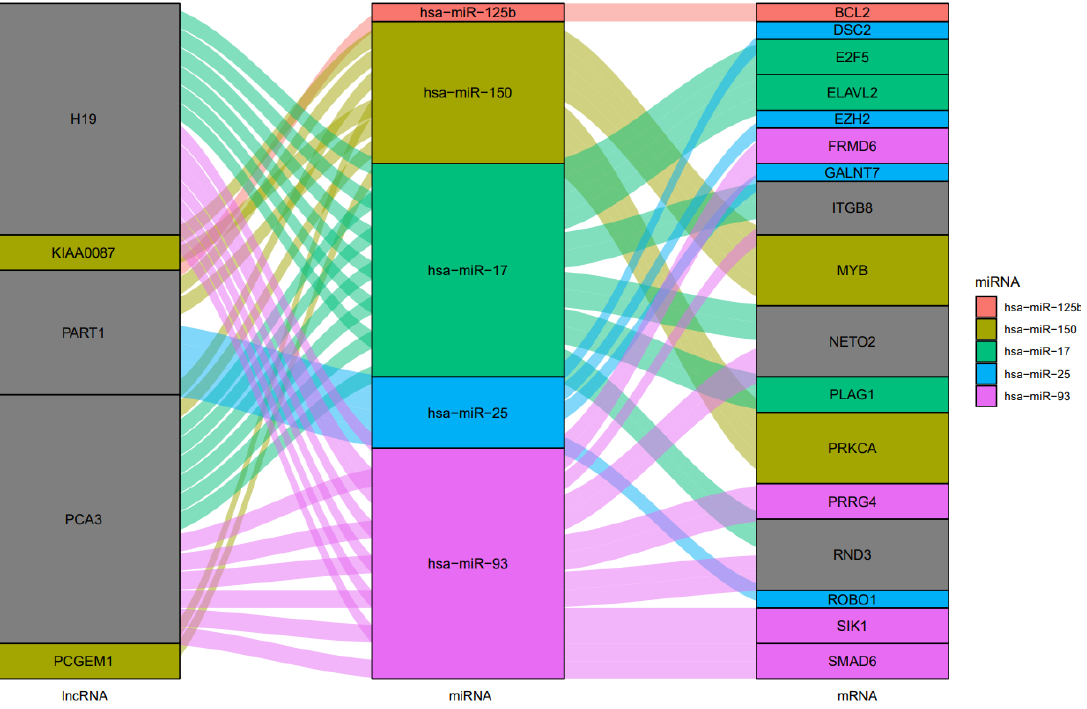
Figure 20. Top 10 genes with highest closeness centrality in ceRNA network. 3.11. Validation of Hub Genes via Expression Value The expression value of hub genes was assessed using the Gepia (http://gepia.cancer- pku.cn/) (accessed on 30 September 2022). Additionally, we used CancerMIRNome (http://bioinfo.jialab-ucr.org/CancerMIRNome/) (accessed on 30 September 2022) to eval- uate the hub miRNA gene expression value. As a result, CAMK2B, CAV1, GPC1, H19, ITGA3, ITGA8, ITGB4, LAMA3, MMP9, MYH11, PCA3, PRKCA, RND3, VEGFA, hsa-